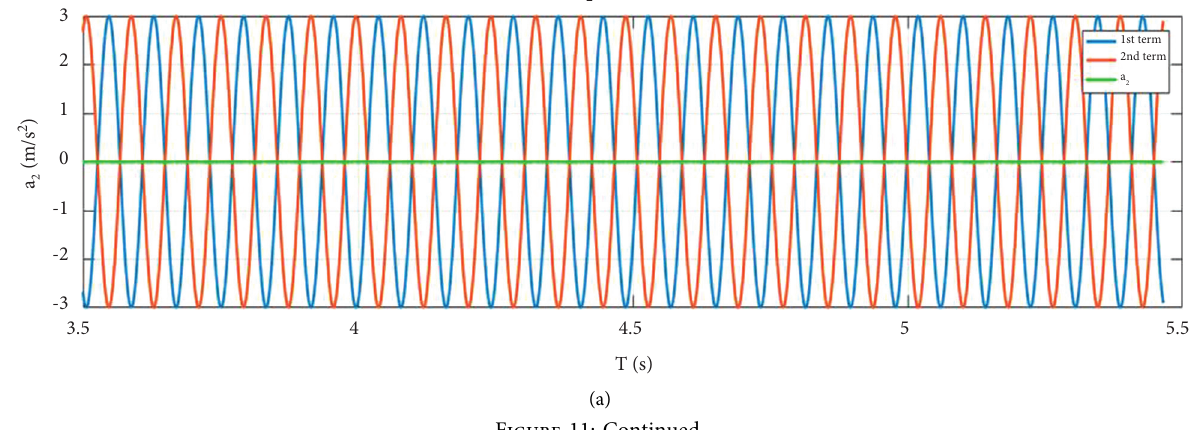
Figure 10: Simulation of the vibration suppression of m term, green: m 2